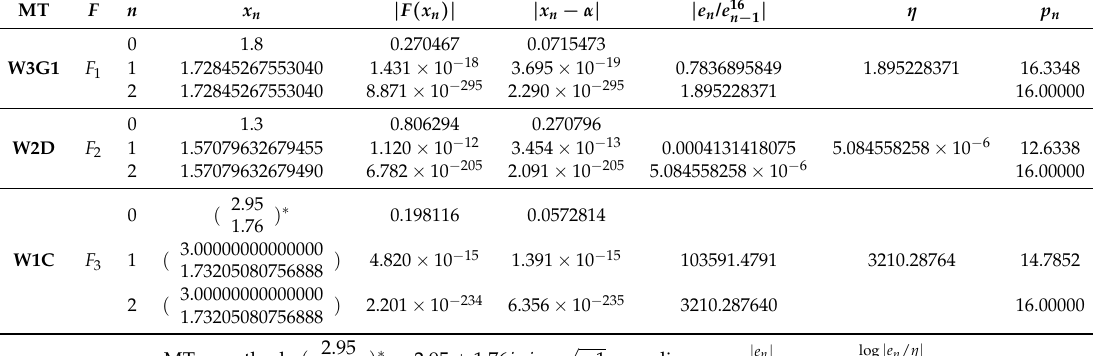
Table 2. Convergence of methods W3G1, W2D, W1C for test functions F 1 ( x ) − F 3 ( x ) shown in